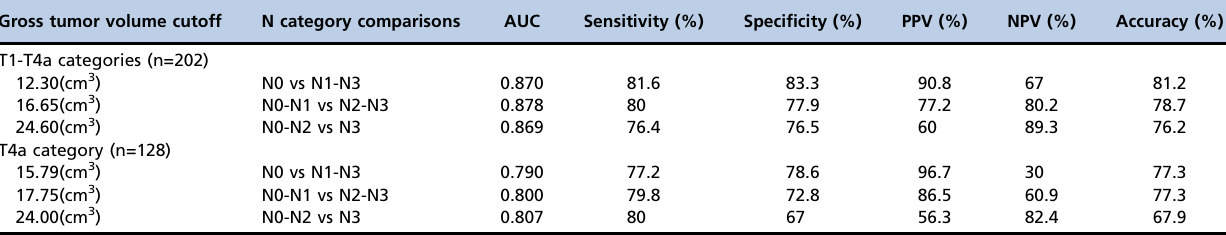
Table 3 - Receiver operating characteristic analysis of accuracy of gross tumor volume of resectable gastric adenocarcinoma in detecting N categories. Gross tumor volume